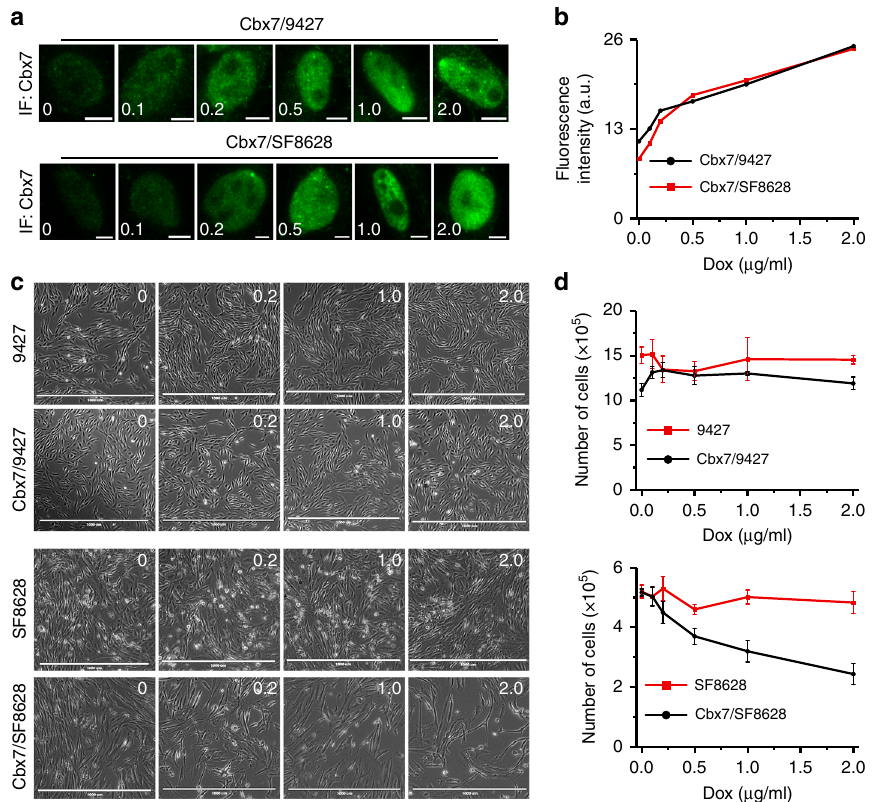
Fig. 7 Increasing Cbx7 levels inhibits the proliferation of patient-derived DIPG cells. a Immunostaining of Cbx7 in 9427 and SF8628 cells carrying transgenic Cbx7 under the control of TRE-tight promoter. The expression of Cbx7 was induced by a variety of doxycycline concentrations. Scale bar, 2.0 µ m. b Quanti fi cation of fl uorescence intensity of Cbx7 from a . c Representative images of proliferation response of 9427 and SF8628 cells to increasing levels of Cbx7. Images of cells treated with 0.1 and 0.5 µ g per ml of Dox are not shown. Scale bar, 1000 µ m. d Quanti fi cation of proliferation response of 9427 and SF8628 cells to increasing levels of Cbx7. Values shown are the average from triplicate samples for each incubation